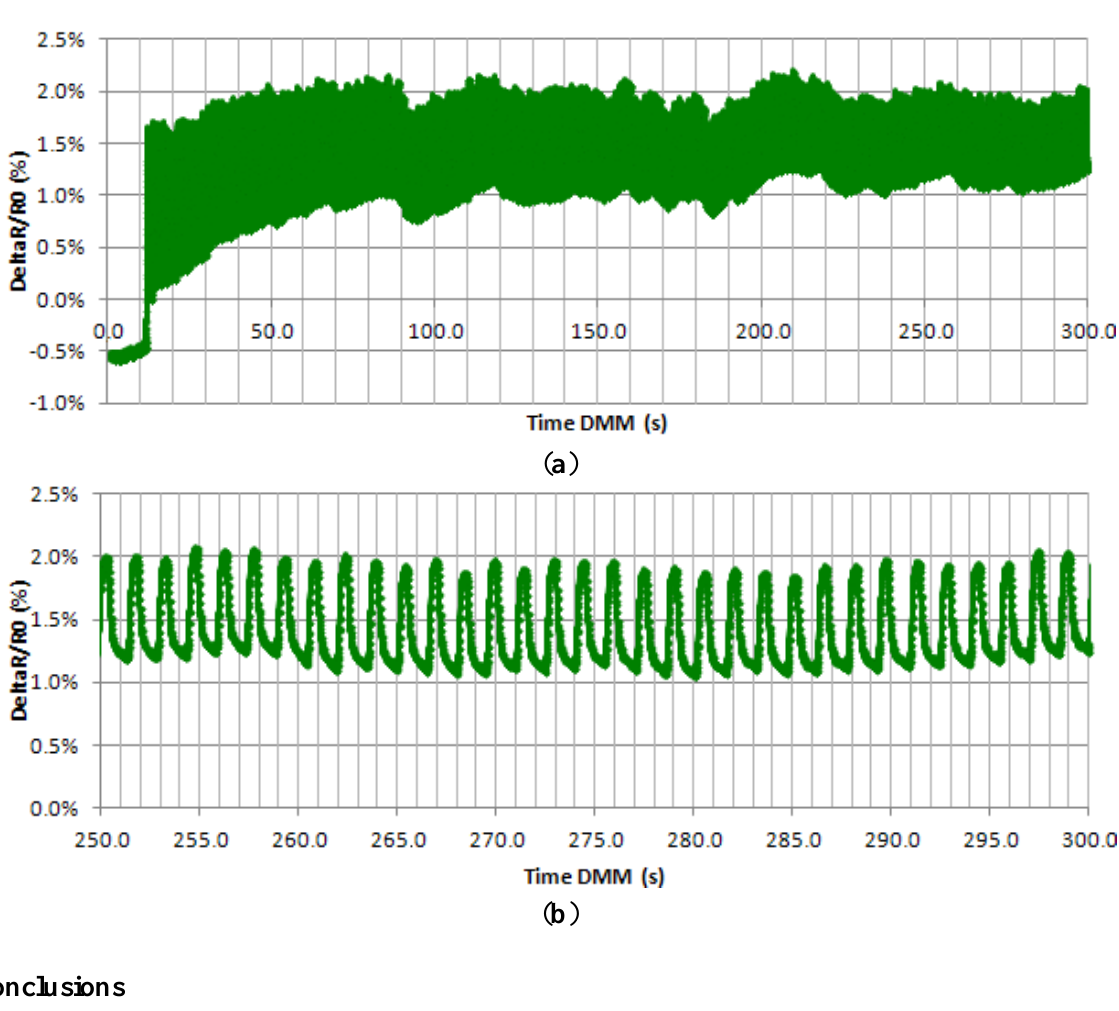
Figure 8. DeltaR/R vs. time of a 24 wt% dry CPP105D and six layers coated sensors on a 0 900 cycles test: ( a ) the first 350 cycles, ( b ) zoom from 250 to 300